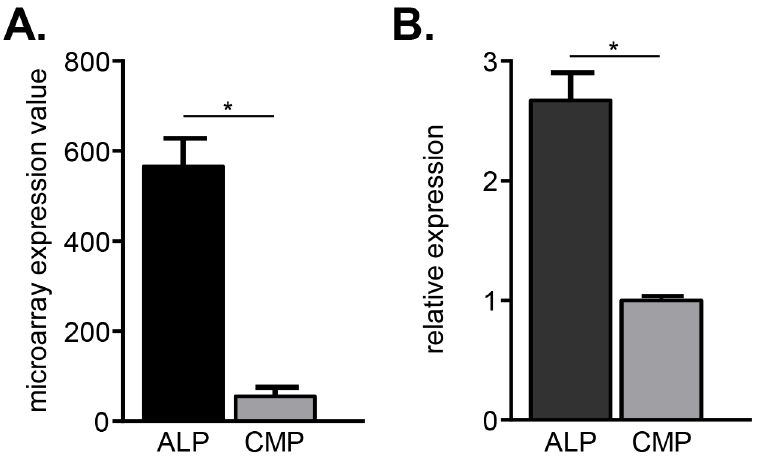
Fig 6. GPR18 is preferentially expressed by lymphoid vs. myeloid progenitors. (A) Microarray expression analysis of GPR18 in all lymphoid progenitors (ALP) and Flk2 + common myeloid progenitors (CMP). Mean values ± SEM are shown; n = 3 microarrays each, derived from previously published work [65, 66]. (B) Quantitative RT-PCR analysis of GPR18 in ALP and Flk2 + common myeloid progenitors CMP. Mean values ± SEM are shown. Gating strategies are shown in S2 Fig. Data are normalized to Gapdh expression levels. * p < 0.05 using students 2-tailed unpaired